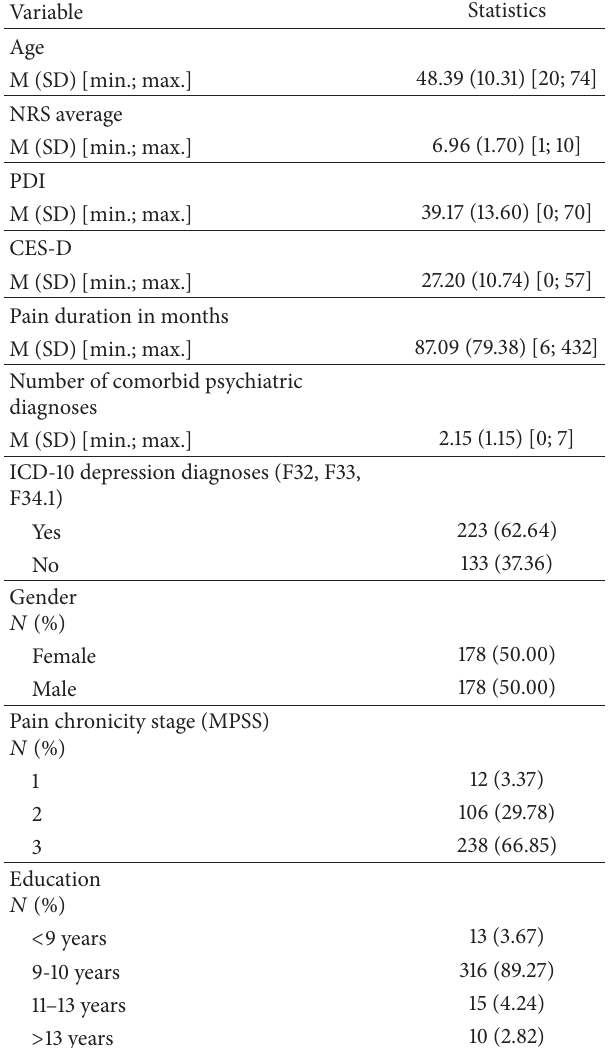
Table 1: Sample description.